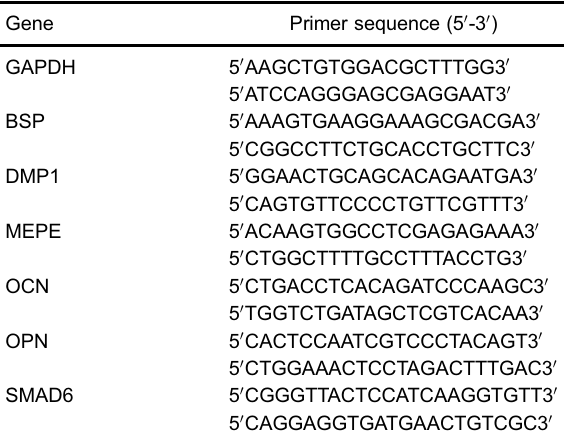
Table 1. Primer sequences for speci fi c genes associated with osteogenic differentiation.